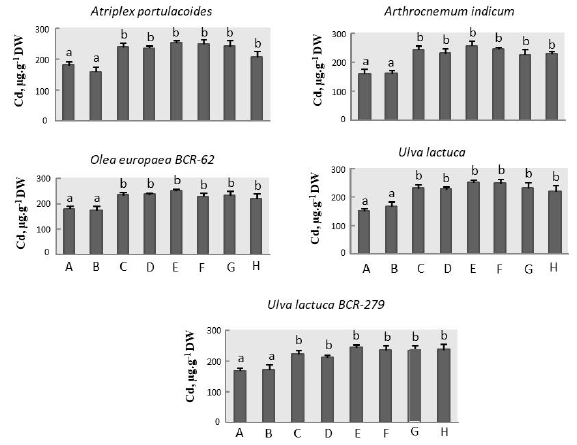
Figure 1. Contents of Cd ( µ g · g − 1 DW) in atriplex portulacoides, arthrocnemum indicum, olea europea BCR-62, ulva lactuca and ulva lactuca BCR-279 using methods A, B, C, D, E, F, G and H. Values were presented as mean ± standard deviation, n = 10. Letters (a, b) show a significant difference ( p < 0.05) between the concentrations attained by different extraction